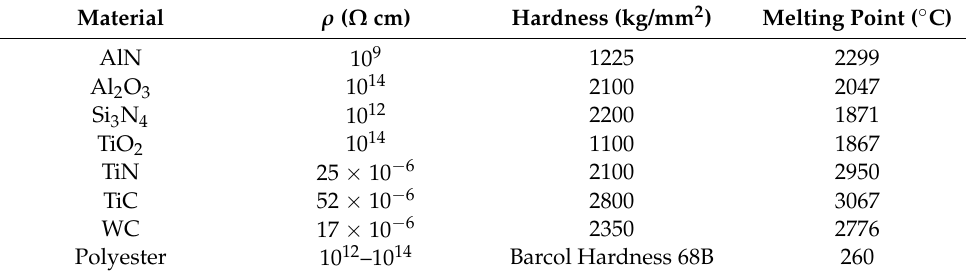
Table 1. The selection of an appropriate material for the substrate.